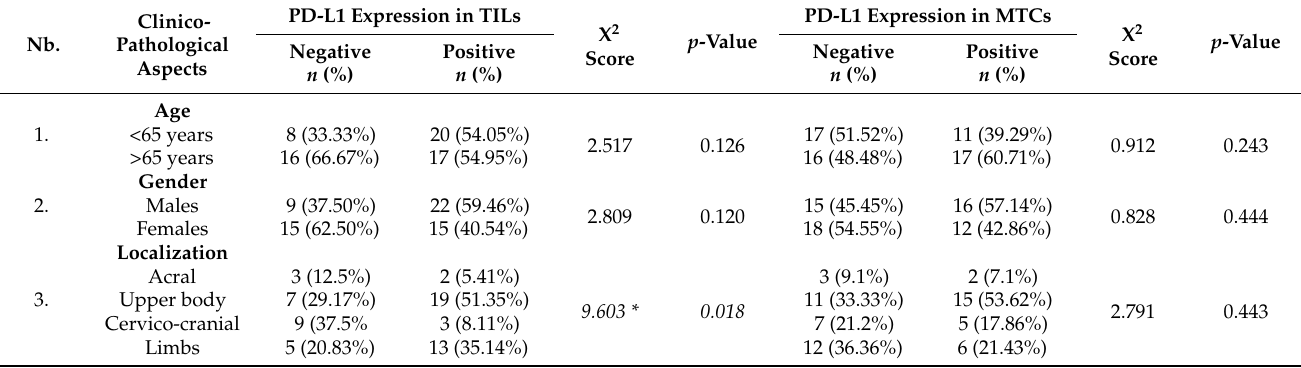
Table 1. Melanoma tumor microenvironment characterization in the function of PD-L1 (+/-) expression.